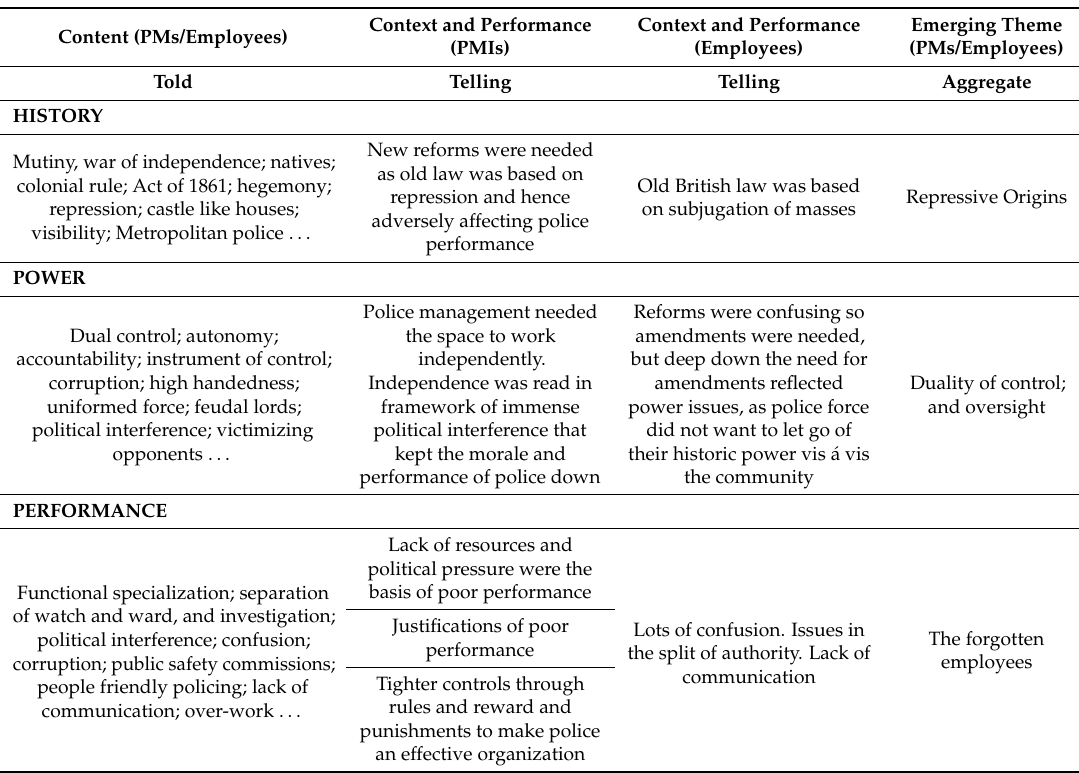
Table 1. Narrative